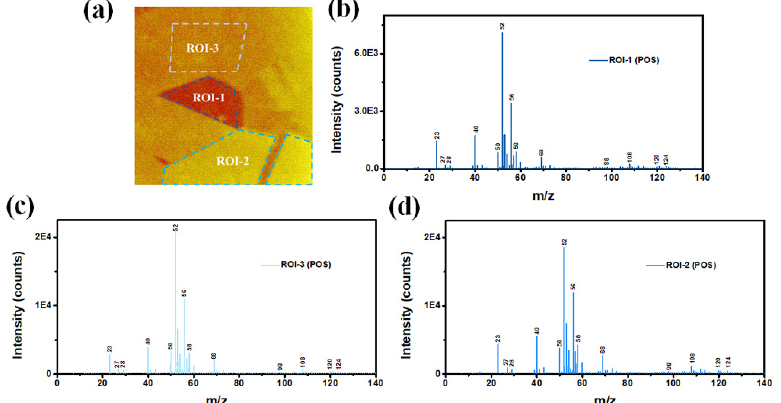
Crystals 2021 , 11 , x FOR PEER REVIEW Figure 5. ( a ) Three ROIs of ToF-SIMS positive ion map, and ( b – d ) their corresponding mass spectra. Figure 5. ( a ) Three ROIs of ToF-SIMS positive ion map, and ( b – d ) their corresponding mass spectra. Figure 5. ( a ) Three ROIs of ToF-SIMS positive ion map, and ( b – d ) their corresponding mass spectra.